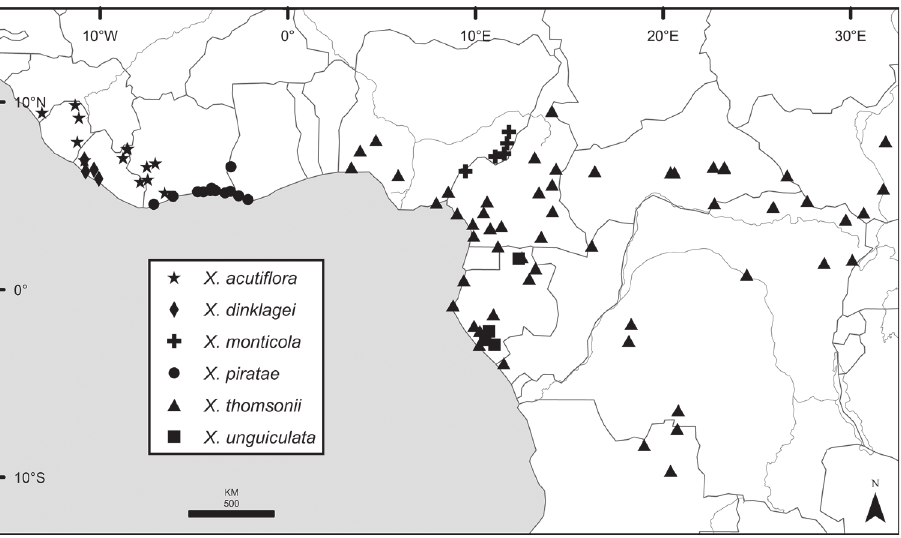
Figure 34. Distributions of Xylopia acutiflora , X. dinklagei , X. monticola , X. piratae , X. thomsonii , and X. unguiculata . Bolder lines represent country borders, fainter lines lakes and major